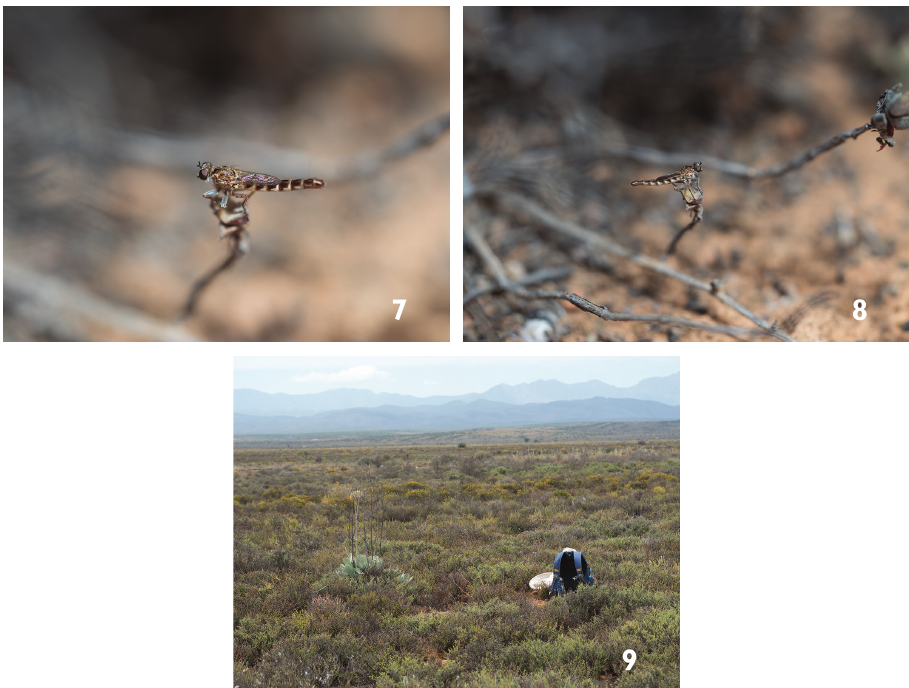
Figures 7–9. Photographs of Trichoura tankwa and habitat: 7–8 female fly perching on low, dry branch (Morphbank #860609; #860611) 9 Little Karoo veld habitat at De Zeekoe Guest Farm near Oudtshoorn, Eastern Cape, South Africa (33°37'26"S 022°08'39"E). Photographs by T. Dikow.